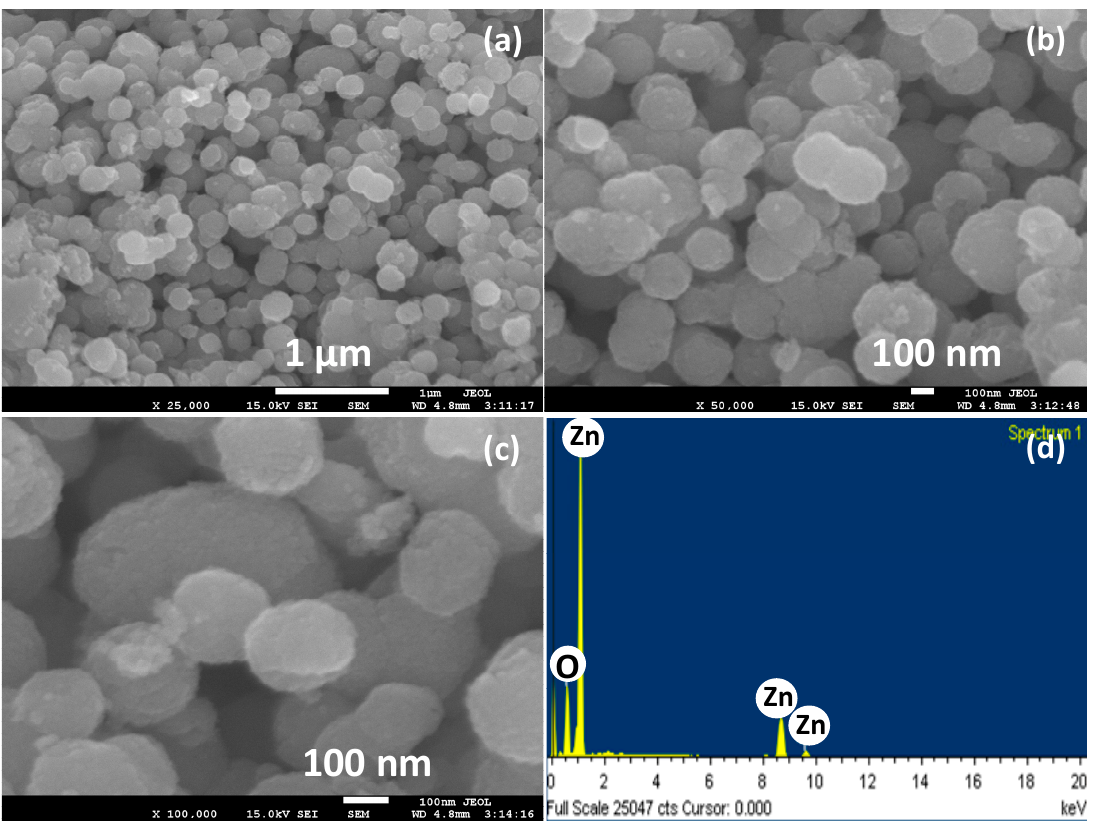
Figure 1. ( a ) Low magnification; and ( b , c ) high magnification FESEM images; and ( d ) EDS spectrum of ZnO nanoballs.